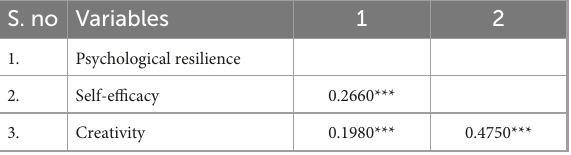
TABLE 2 Correlations among variables.